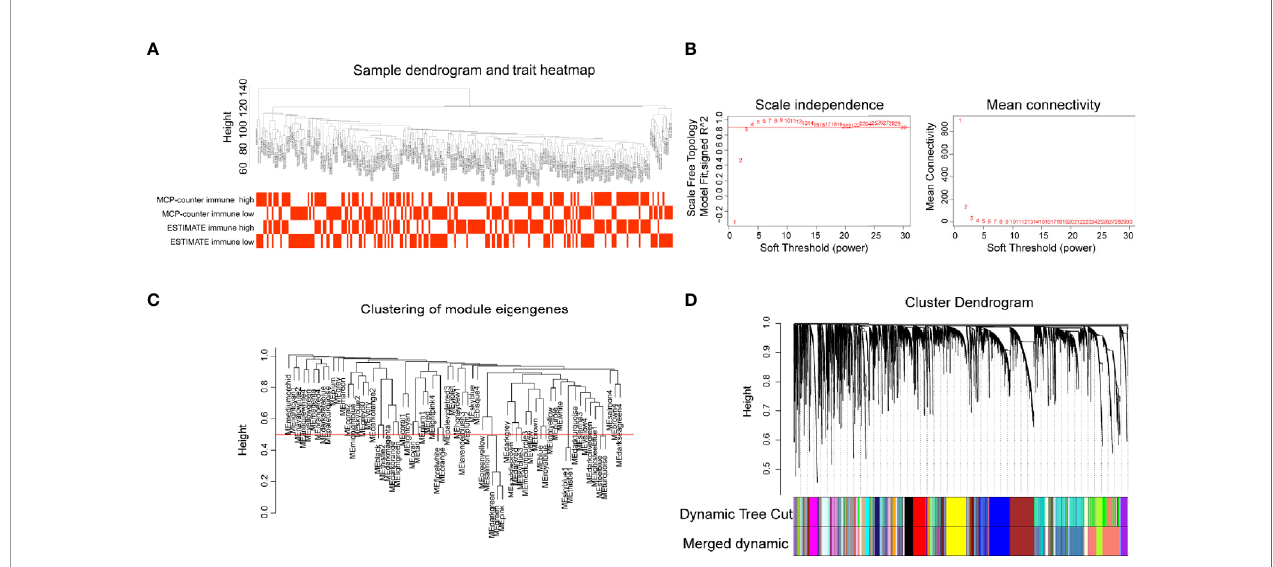
FIGURE 2 | Gene modules construction by weighted gene co-expression network analysis (WGCNA). (A) Sample dendrogram and trait heatmap. (B) The relationship of soft threshold with scale independence and mean connectivity. (C) Clustering of module eigengenes, height set at 0.5 to merge modules. (D) Cluster dendrogram showing the hierarchical cluster tree for the identi fi ed co-expression gene modules with different